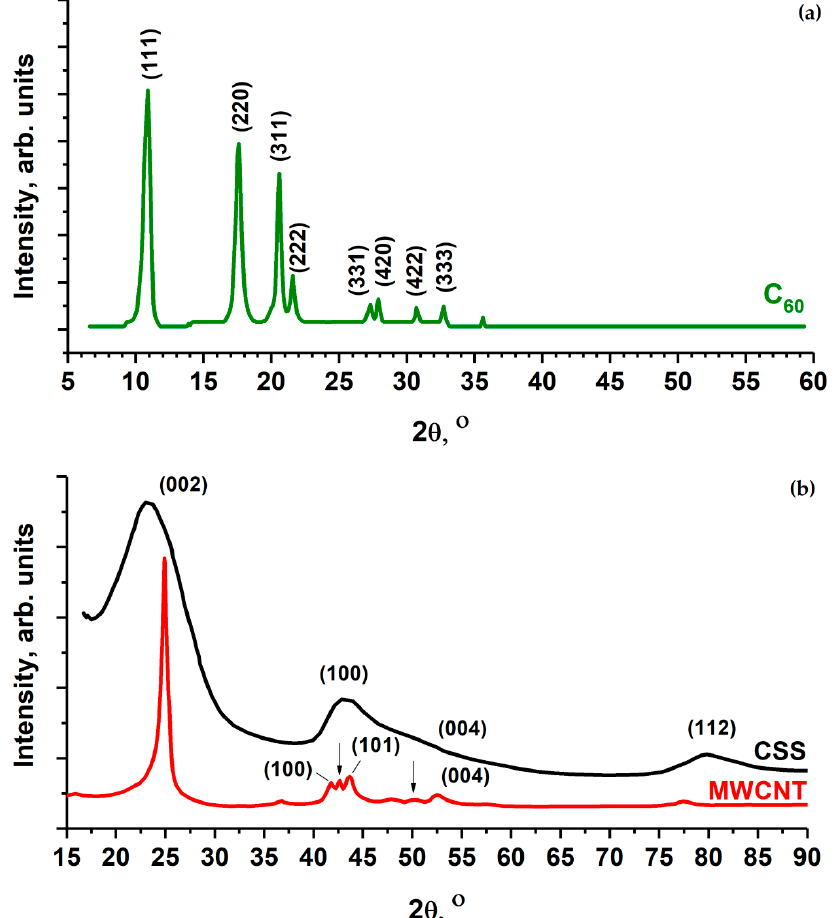
Figure 2. XRD characterization of the C 60 ( a ) and MWCNT, CSS powders ( b ). The arrows indicate the positions of diffraction peaks of γ‐ Fe from the iron catalyst. The XRD pattern of MWCNT (Figure 2b) consists of four peaks characteristic of graphite: (100), (002), (004) and (112). Moreover, diffraction peaks marked with an arrow in Figure 2b prove the presence of residual iron catalyst ( γ -Fe) in the MWCNT inner